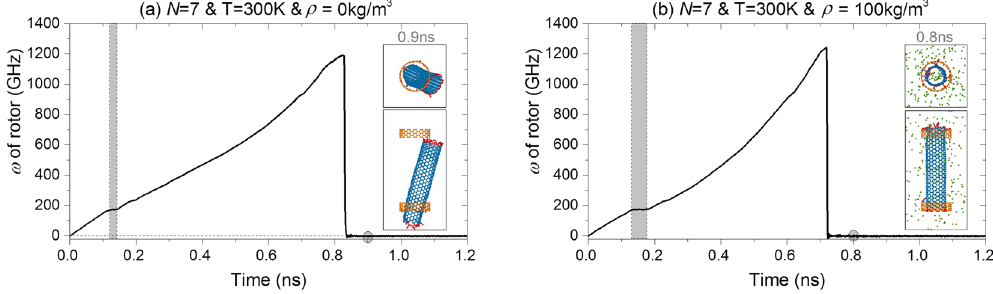
Figure 4. History of rotational frequency of a rotor in a nanomotor with N = 7 with or without argon atoms in the simulation box at 300 K. ( a ) Without argon atoms, ( b ) with argon density of 100 kg/m 3 .